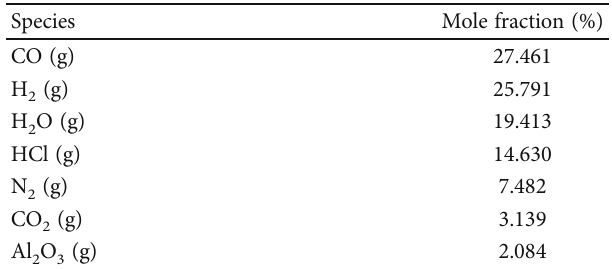
Table 1: Compositions of combustion products in the combustion